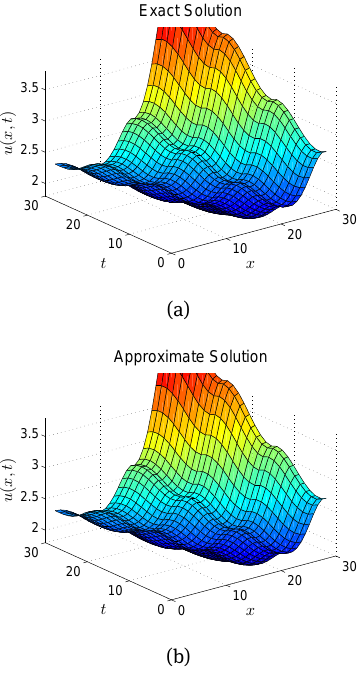
Figure 7: Analytical and approximate solution for example 6 at (a) t = 2 and (b) t = 16